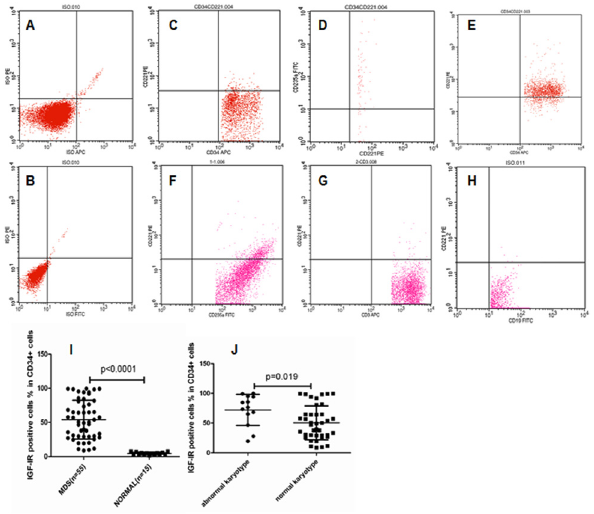
Fig 1. Expression of IGF-IR in CD34+ cells from normal controls and in CD34+ cells, erythroid lineage cells, T lymphocytes, and B lymphocytes from MDS patients. (A) and (B) were isotype controls for the detection. (C) The expression of IGF-IR on CD134+ cells from 1 normal control was 4.3%. (D) Of these CD34+ IGF-IR+ cells, 75.3% expressed the erythroid lineage marker CD235a. (E) The expression of IGF-IR on bone marrow CD34 + cells was 82.9% in 1 MDS patient. (F) IGF-IR was expressed on the surface of 15.8% erythroid lineage cells from the same MDS patient. There was not significant expression of IGF-IR on the T lymphocytes (G) or B lymphocytes (H) from the same MDS patient. (I) The expression of IGF-IR of CD34 + cells from the 55 MDS patients was significantly higher than that of cells from the normal controls (54.0 vs. 4.5%; P < 0.0001). (J) The expression of IGF-IR of CD34 + cells in the abnormal chromosome group was significantly higher than that in the normal chromosome group (72.0 vs. 50.4%; P =